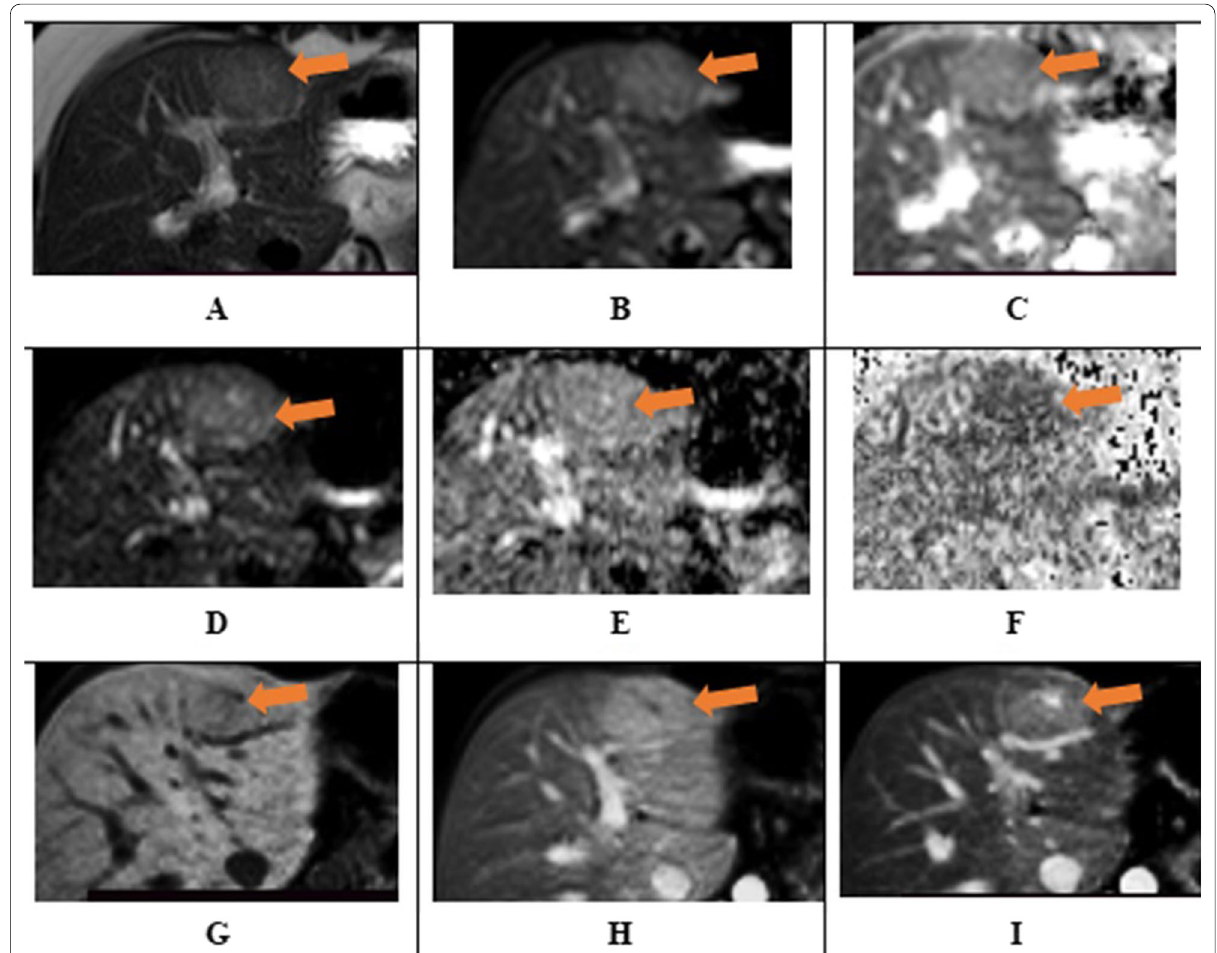
Fig. 5 A 27-year-old female patient with past history of viral C hepatitis underwent routine abdominal ultrasonography that showed left hepatic focal lesion. A Axial T2 image shows A 3.7 cm left lobar segment III focal lesion eliciting high T2 signal with central hypo-intense scar. B axial diffusion and C ADC images show no diffusion restriction with DWI-ADC value 1.51 D Axial DTI gray scale image, E DTI-ADC map and F FA map: the DTI-ADC value was 1.57 and the FA value was low 0.26 suggestive of benign nature. G non-contrast T1 H arterial phase and I delayed phase of the = dynamic study showed homogenous arterial enhancement with enhancement of the central scar in the delayed phase. The lesion was categorized as LR-3. Imaging features were suggestive of FNH which is proved by